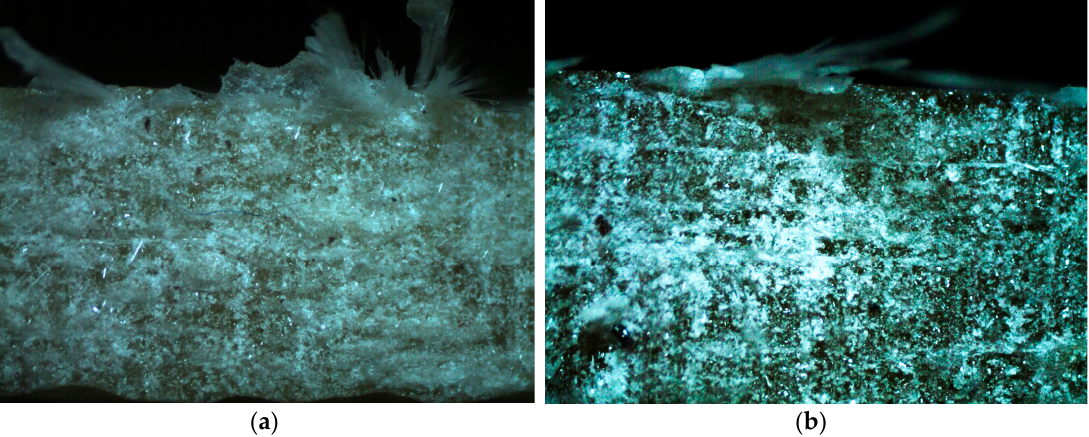
Figure 5. Some examples of the worn composite surfaces with the polymer matrices MC-DUR 1200VK and the particulate filler proportions of 10 wt.%: ( a ) with the emulsion binder; ( b ) with the powder binder.